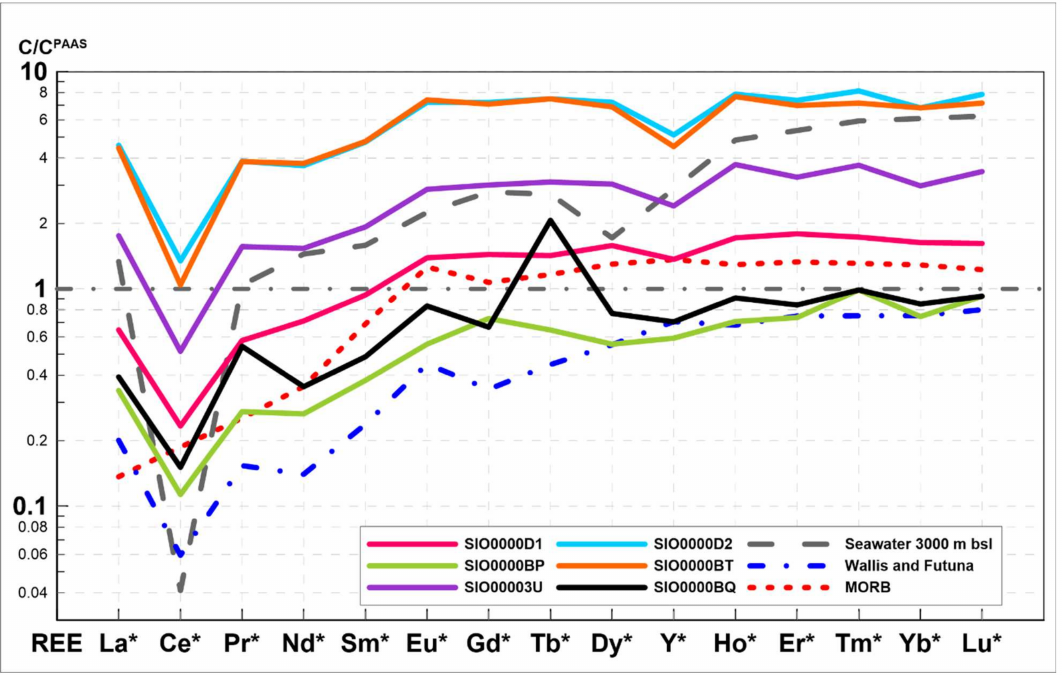
Figure 5. The PAAS-normalized REE distribution in Fe-Mn crusts from C-NSC (PAAS